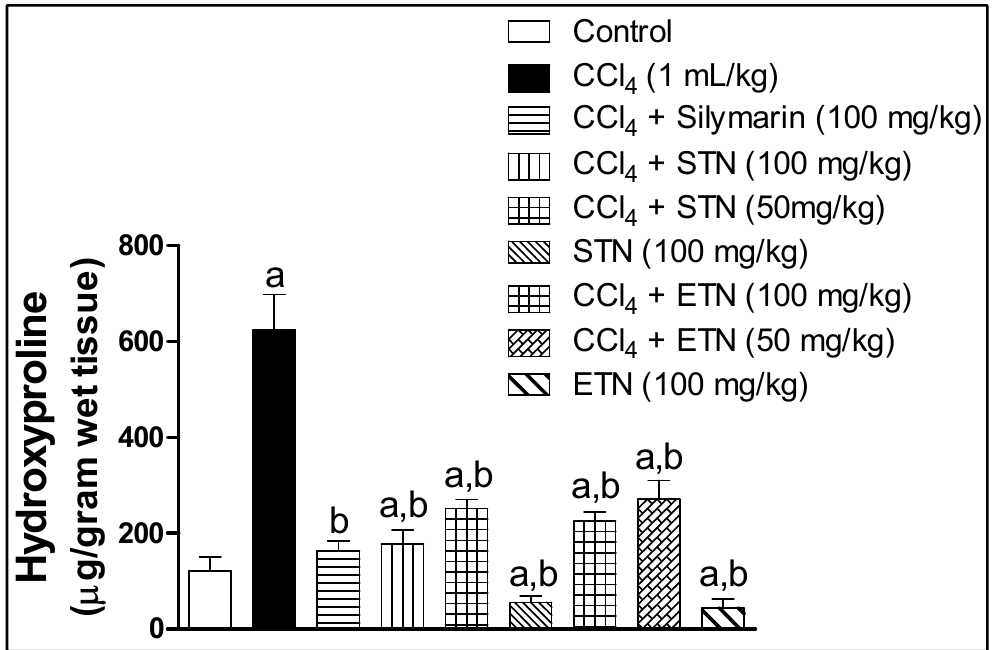
Figure 5. Effect of ETN and STN on liver hydroxyproline content rats subjected to chronic CCl 4 intoxication. * Data are the mean ± SD ( n = 6). a or b: Significantly different from control or CCl 4 group respectively at p < 0.05 using ANOVA followed by Tukey-Kramer as a post-hoc test.